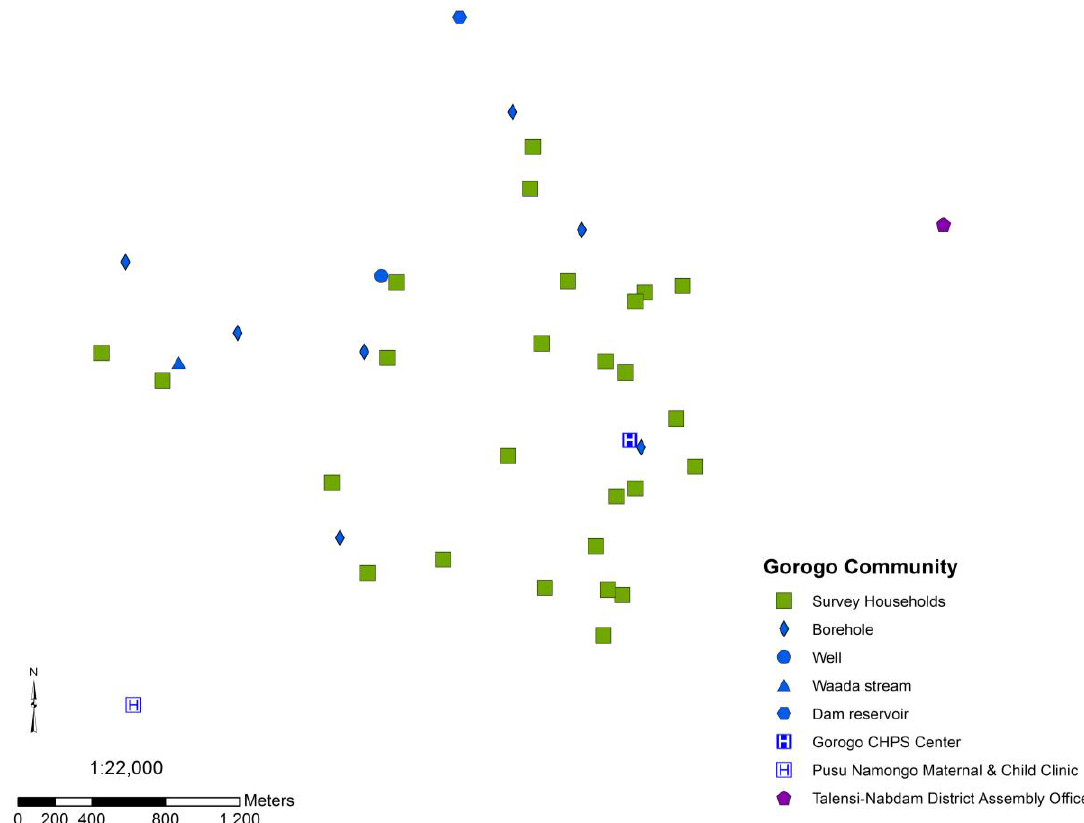
Figure S1. Map of Gorogo households surveyed and community